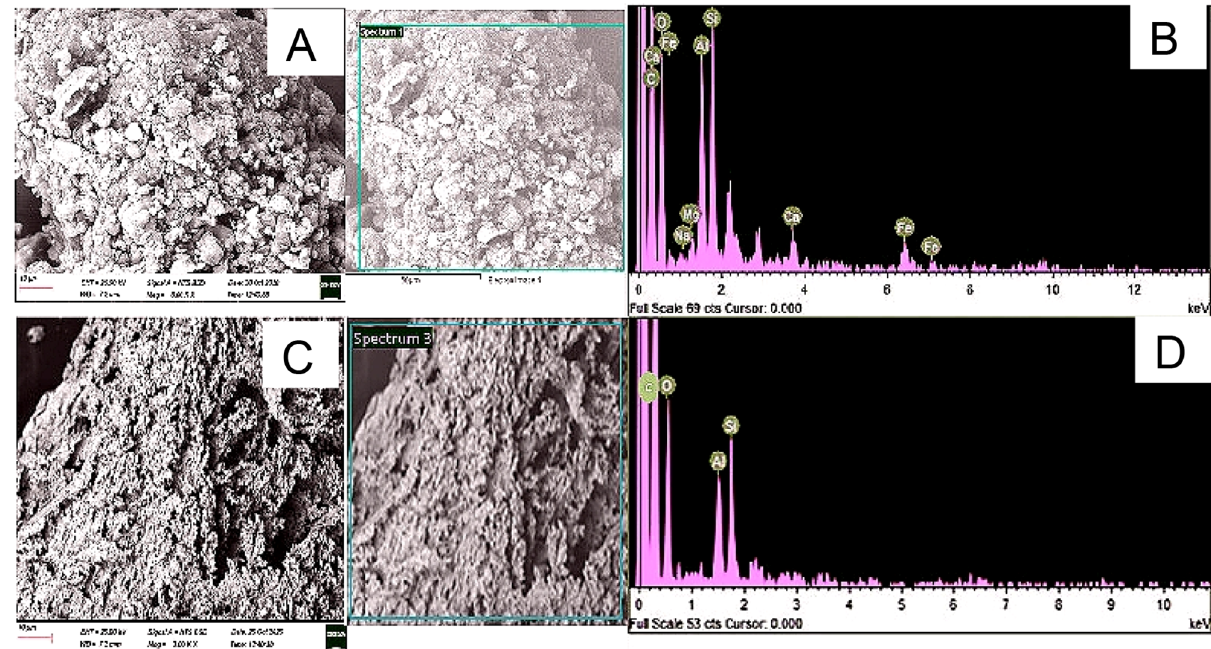
Figure 11. SEM images ( A , C ) and EDX elemental spectrums ( B , D ) of coal tailing (up), and coal tailing’s hydrochar